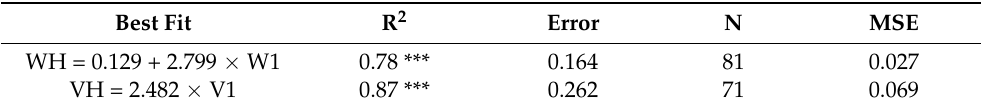
Figure 3. Relationship between fruit dry weight ( a ) and volume ( b ) at the end of Phase I of endocarp development vs. at harvest. Green circle, cv Cornicabra; Blue triangle, cv Arbequina; Red square, cv Manzanilla. Dashed lines represent the best fit with all data of cvs Cornicabra and Arbequina. Short dash lines represent the best fit obtained for cv Manzanilla with published data (see below). Each point is individual plot data of each season and cultivar. Table 5. Best fit of the relationships between dry weight and volume at Period 1 and harvest (Figure 4). The regression of dry weight included all data of the three cultivars. In the regression of volume, only data of cv Arbequina and Cornicabra were considered.